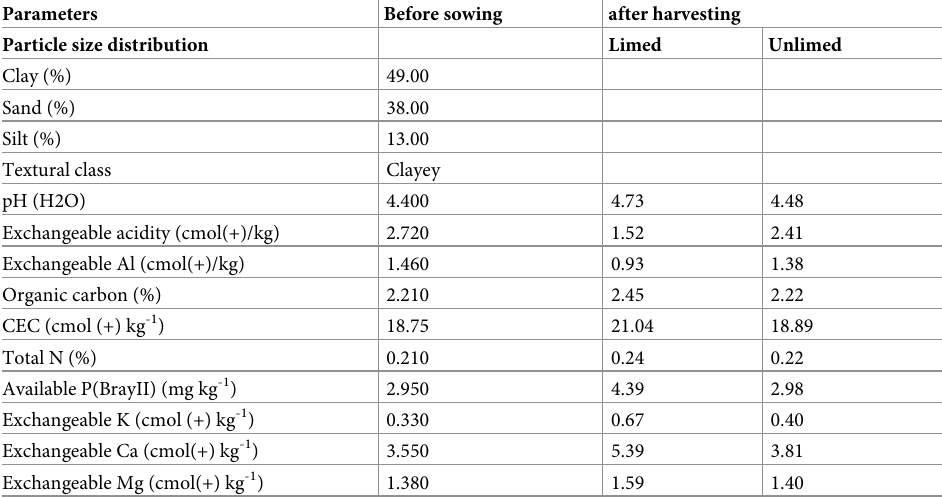
Table 1. Physicochemical properties of the experimental soil prior to sowing and after harvesting.